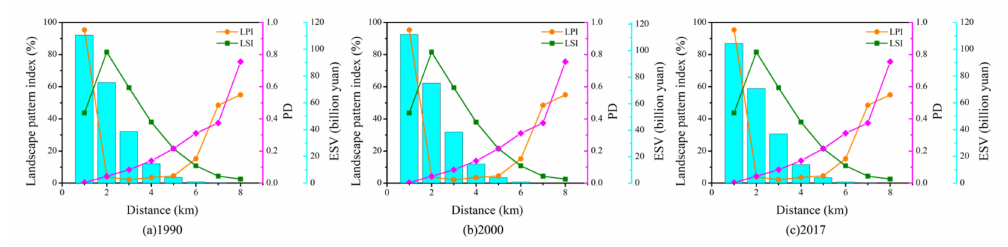
Figure 7. Landscape index and ESVs changes in ( a – c ) river buffer